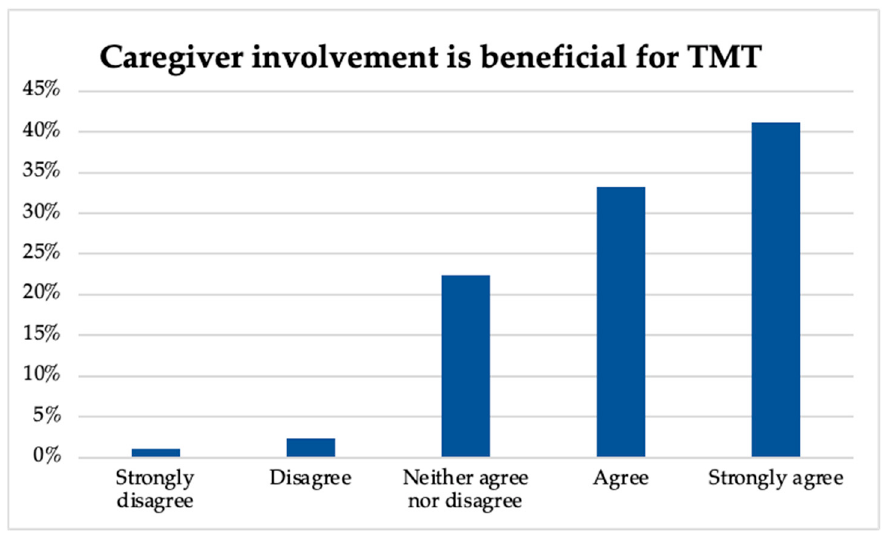
Figure 4. Perceptions of caregiver involvement during TMT.